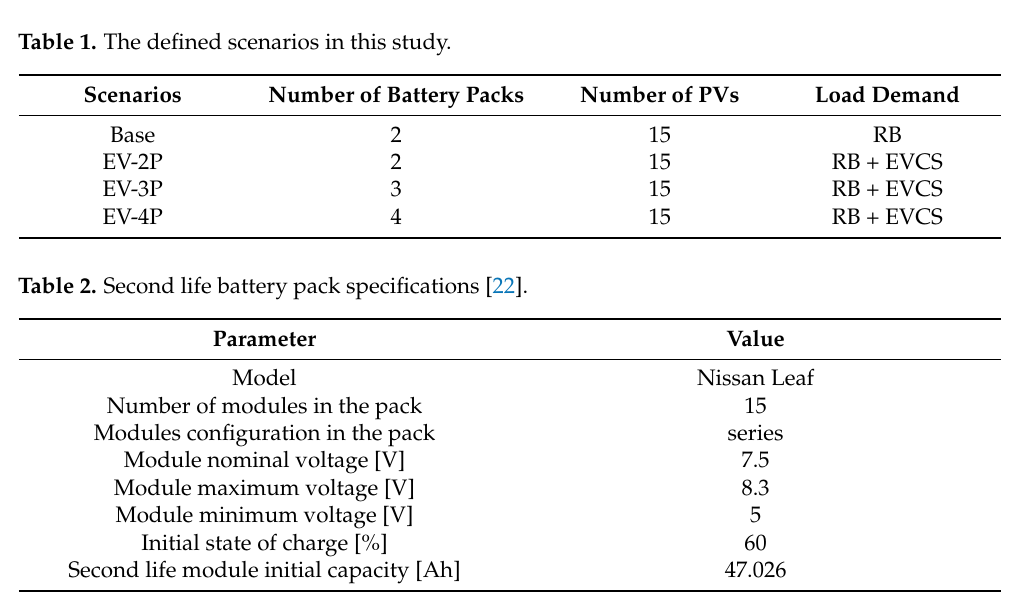
Table 3. Solar PV panel specifications [23].